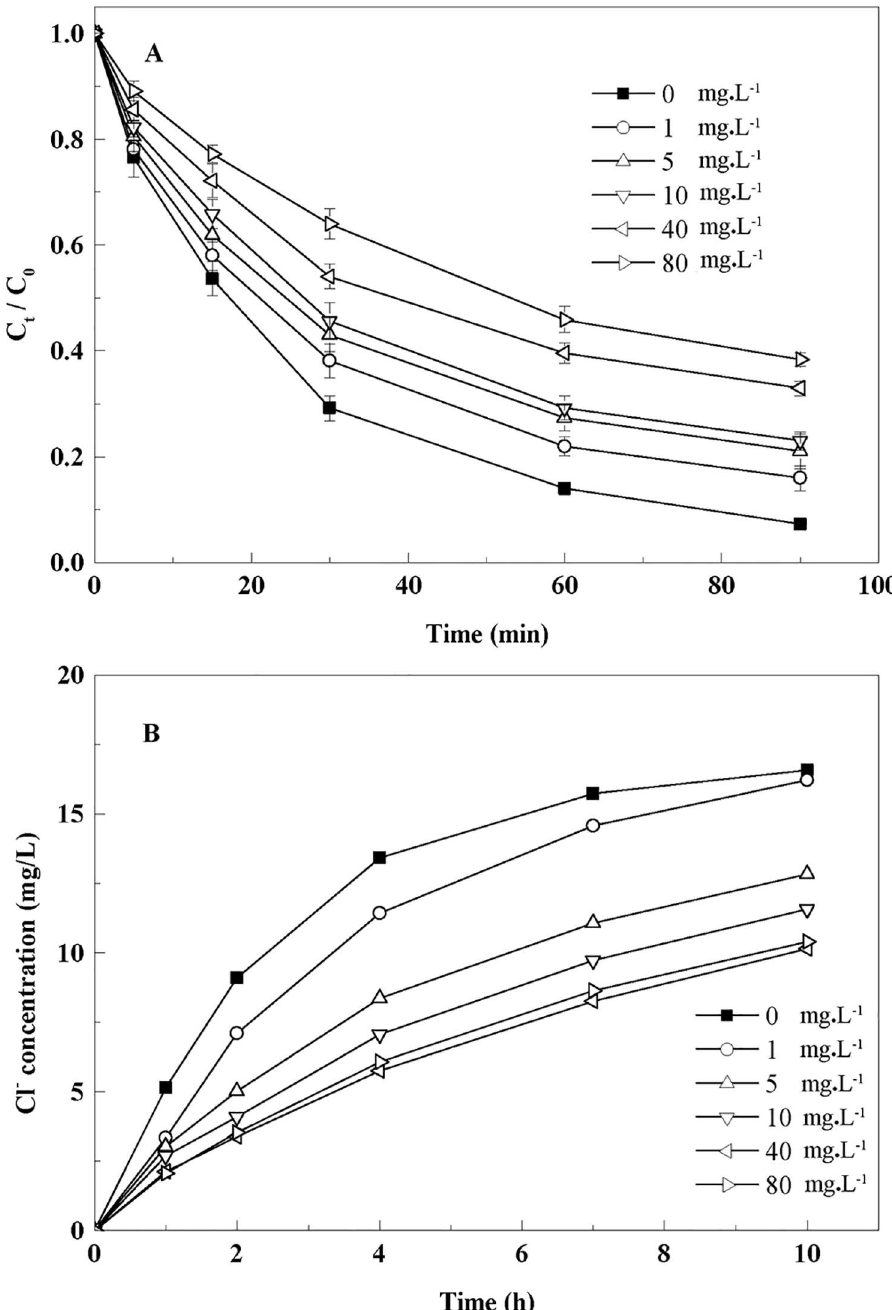
Fig 4. Removal of TCE by the BC-nZVI in the presence of Humic Acid (HA). A , Effect of HA on the removalof TCE by BC-nZVI at different HA concentrations; B , Cl − concentrations in solutionswith different HA